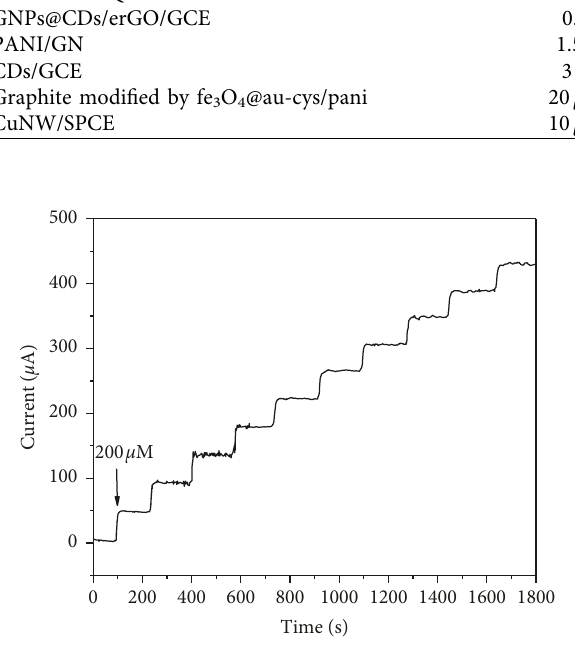
Figure 5: Amperometric responses of CuNW/SPCE upon the successive addition of UA at 0.6V (0.1 M NaOH).